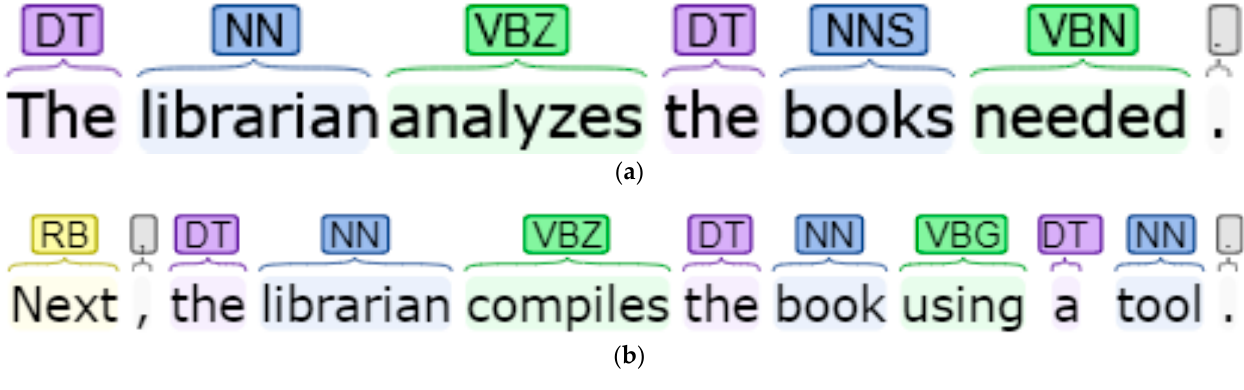
Figure 1. Part-of-speech of ( a ) sentence 1 and ( b ) sentence 2.